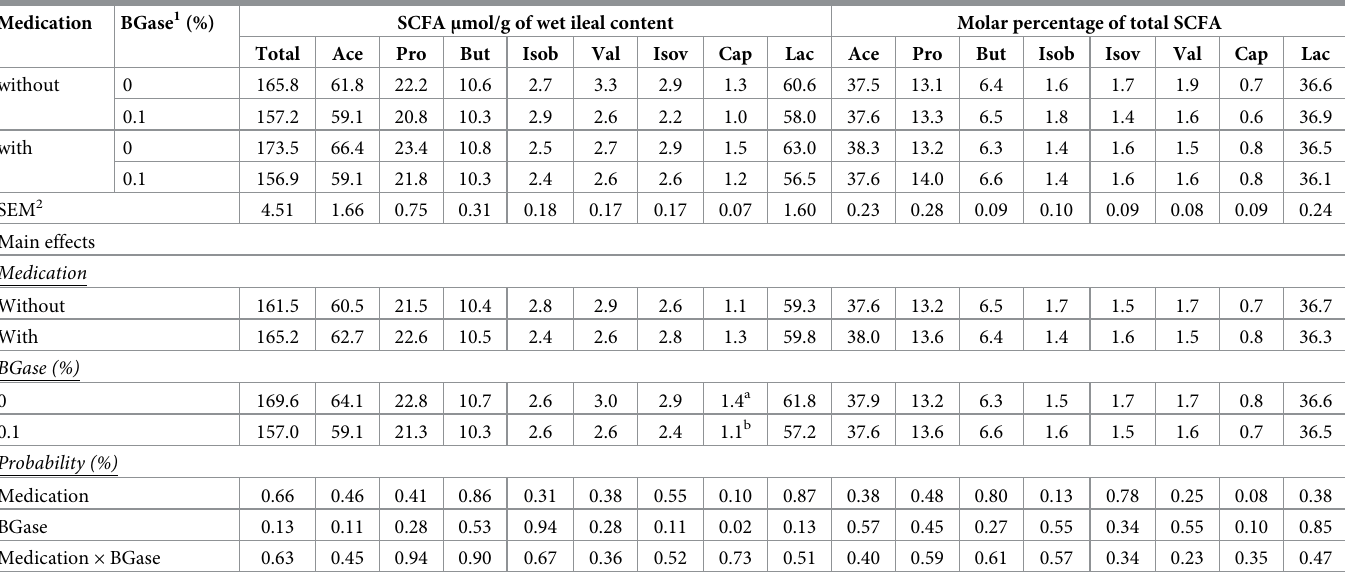
Table 4. Effects of diet medication and β -glucanase on ileal digesta short chain fatty acids of broiler chickens at 28 days of age (Experiment 1). Medication BGase 1 (%)